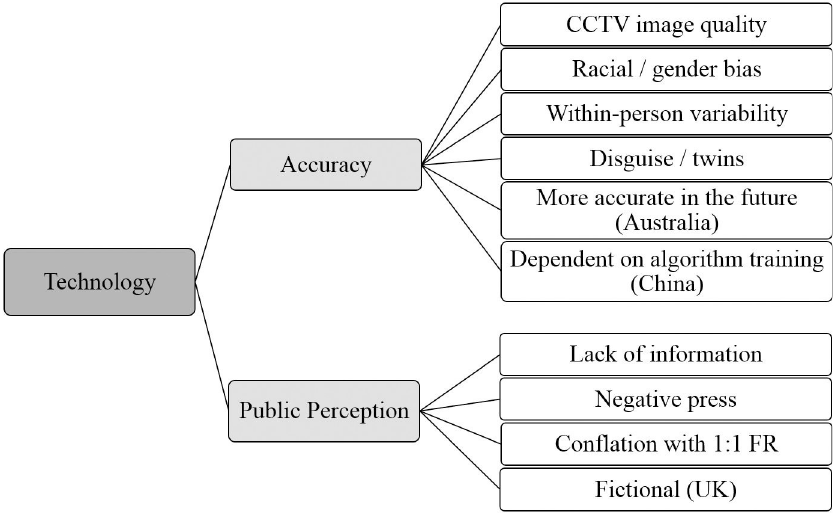
Fig 3. Technology overarching theme. Graphical representation of Technology overarching theme and its component themes and subthemes identified from focus groups conducted in the UK, Australia and China.